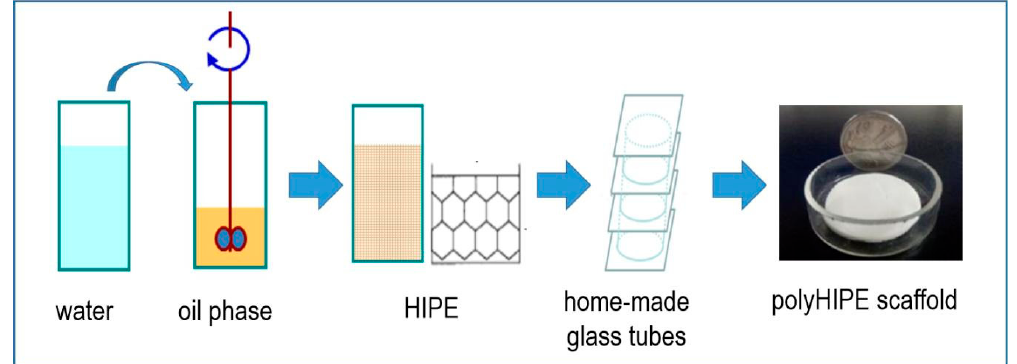
Figure 1. Synthesis pathway of the porous polyHIPE scaffolds.